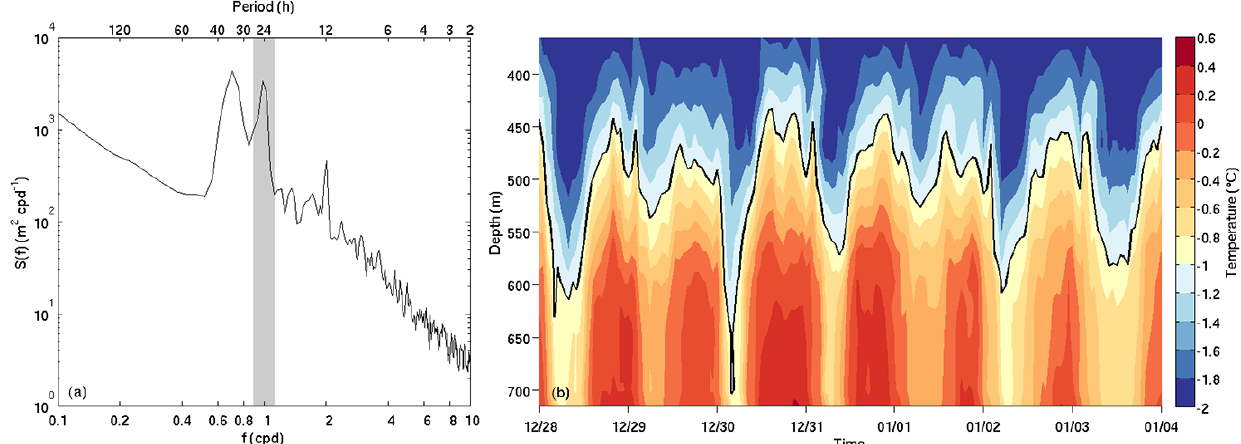
Figure 13. (a) Power spectral density of the height above the bottom of the − 1 ◦ C isotherm, which indicates the transition between WW and WDW at M3. The diurnal tidal frequency band is marked in grey. (b) Hovmöller diagram of low-passed filtered temperature at mooring M3 from 28 December to 4 January. The − 1 ◦ C isotherm is shown by a black line.